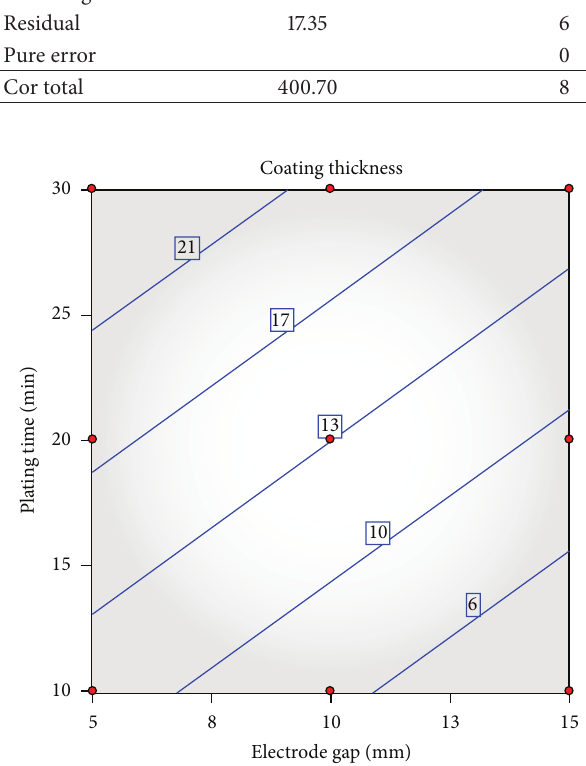
Figure 4: Response surface graph of contours for coating thickness.